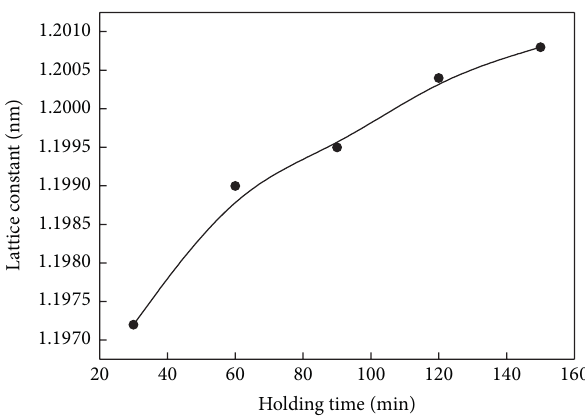
Figure 3: Lattice constants of samples with different holding times.